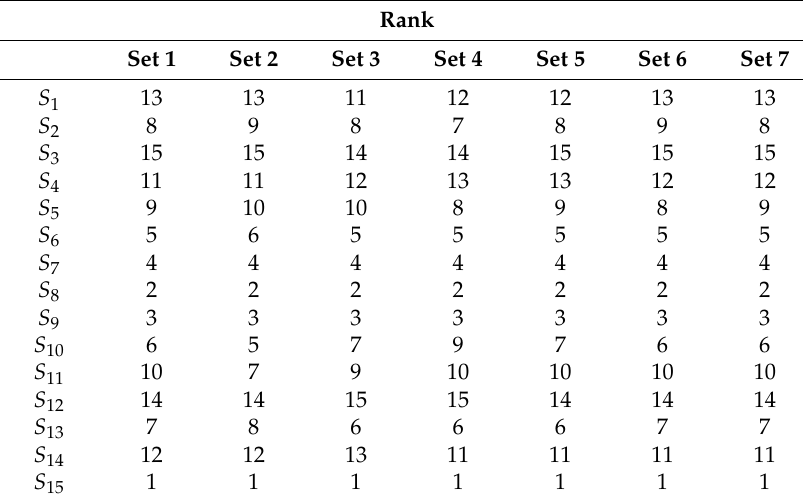
Table 9. Results of the sensitivity